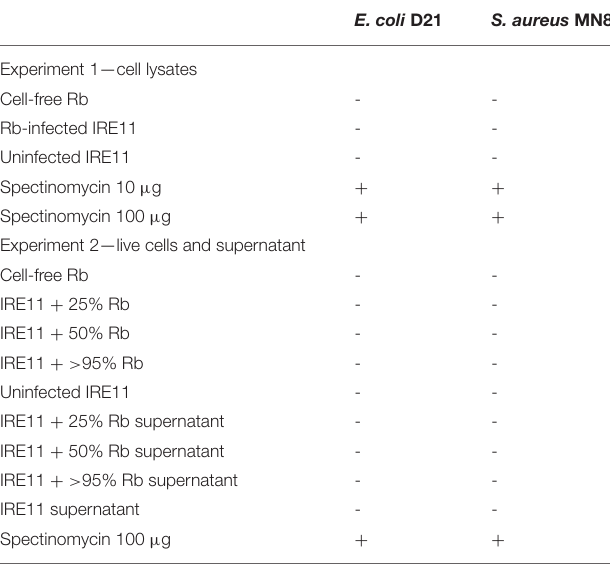
TABLE 4 | Results from antibiotic susceptibility tests (disk diffusion assays) against E. coli and S. aureus .